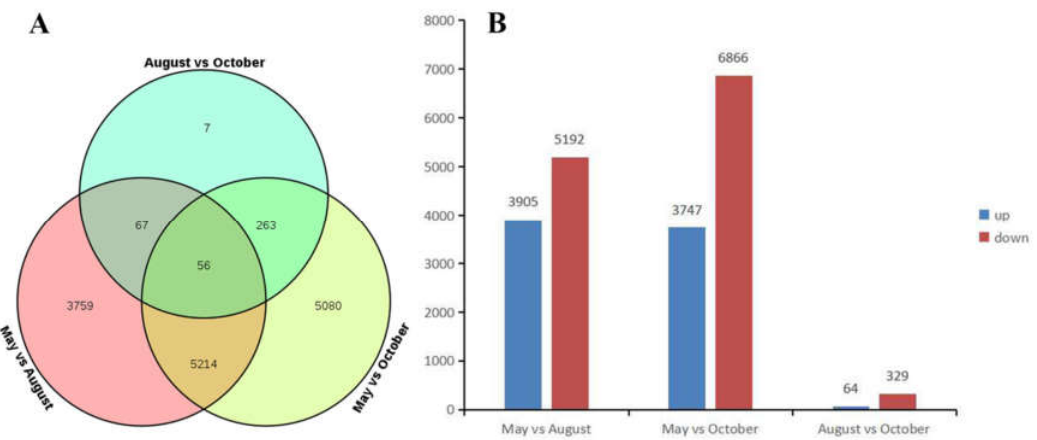
Figure 5. ( A ) The Venn diagram of the number of differentially expressed genes (DEGs); ( B ) The number of up-regulated and down-regulated DEGs.